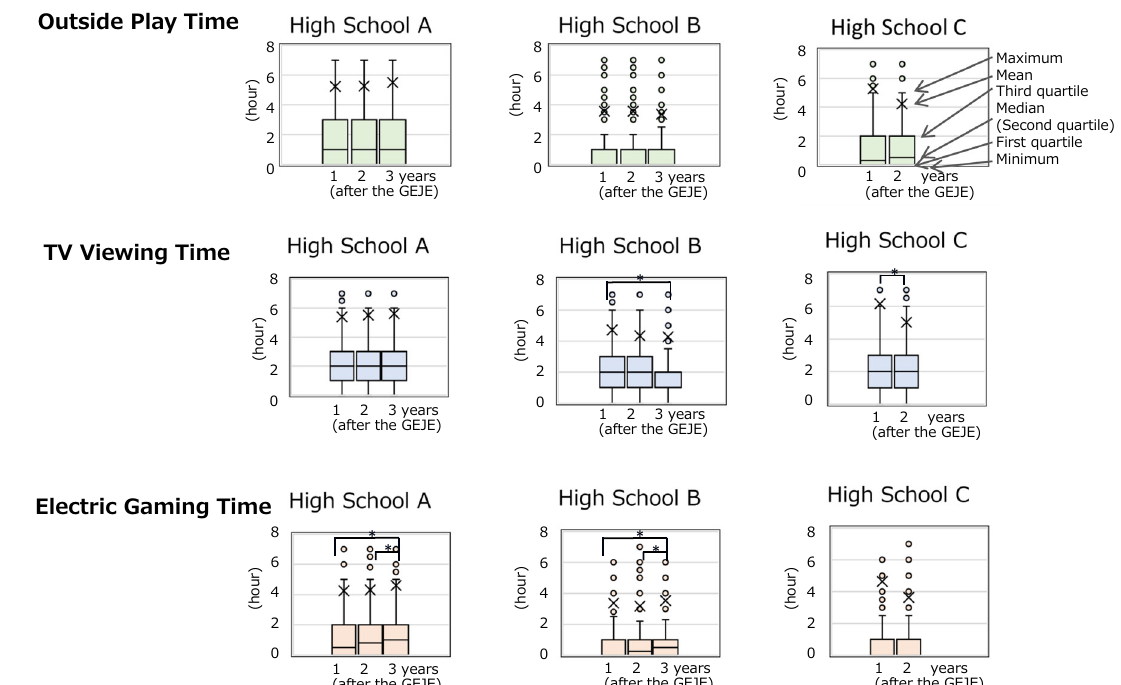
Fig. 4 Differences in daily life activities due to tsunami damage. QIDS-J Quick Inventory of Depressive Symptomatology — Japanese version; SAS Zung Self-Rating Anxiety Scale, IES-R, Impact of Event Scale — Revised; CD-RISC-10, 10-item Conner-Davidson Resilience Scale; GEJE, Great East Japan Earthquake. *According to the Kruskal – Wallis test, there was a difference in time between 2012, 2013, and 2014 ( P < 0.05); according to the Mann – Whitney U -test, there was a difference in time by between 2012 and 2013 ( P <